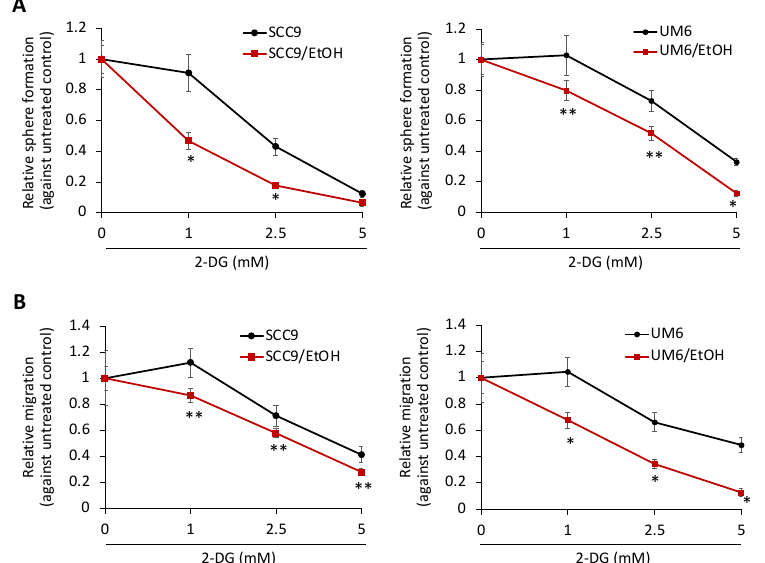
Figure 4. EtOH-exposed OSCC cells depend on glycolysis for their stemness property. ( A ) Effect of glycolysis inhibitor 2-DG on self-renewal capacity of EtOH-exposed OSCC and their untreated con- trols were determined by tumor sphere formation assay. The assay was performed in the tumor sphere medium containing indicated 2-DG concentrations (0–5 mM), and the numbers of tumor spheres were counted. * p < 0.001, ** p < 0.05. ( B ) Effect of 2-DG on migration capacity of EtOH-exposed OSCC and their untreated controls were determined by transwell migration assay.